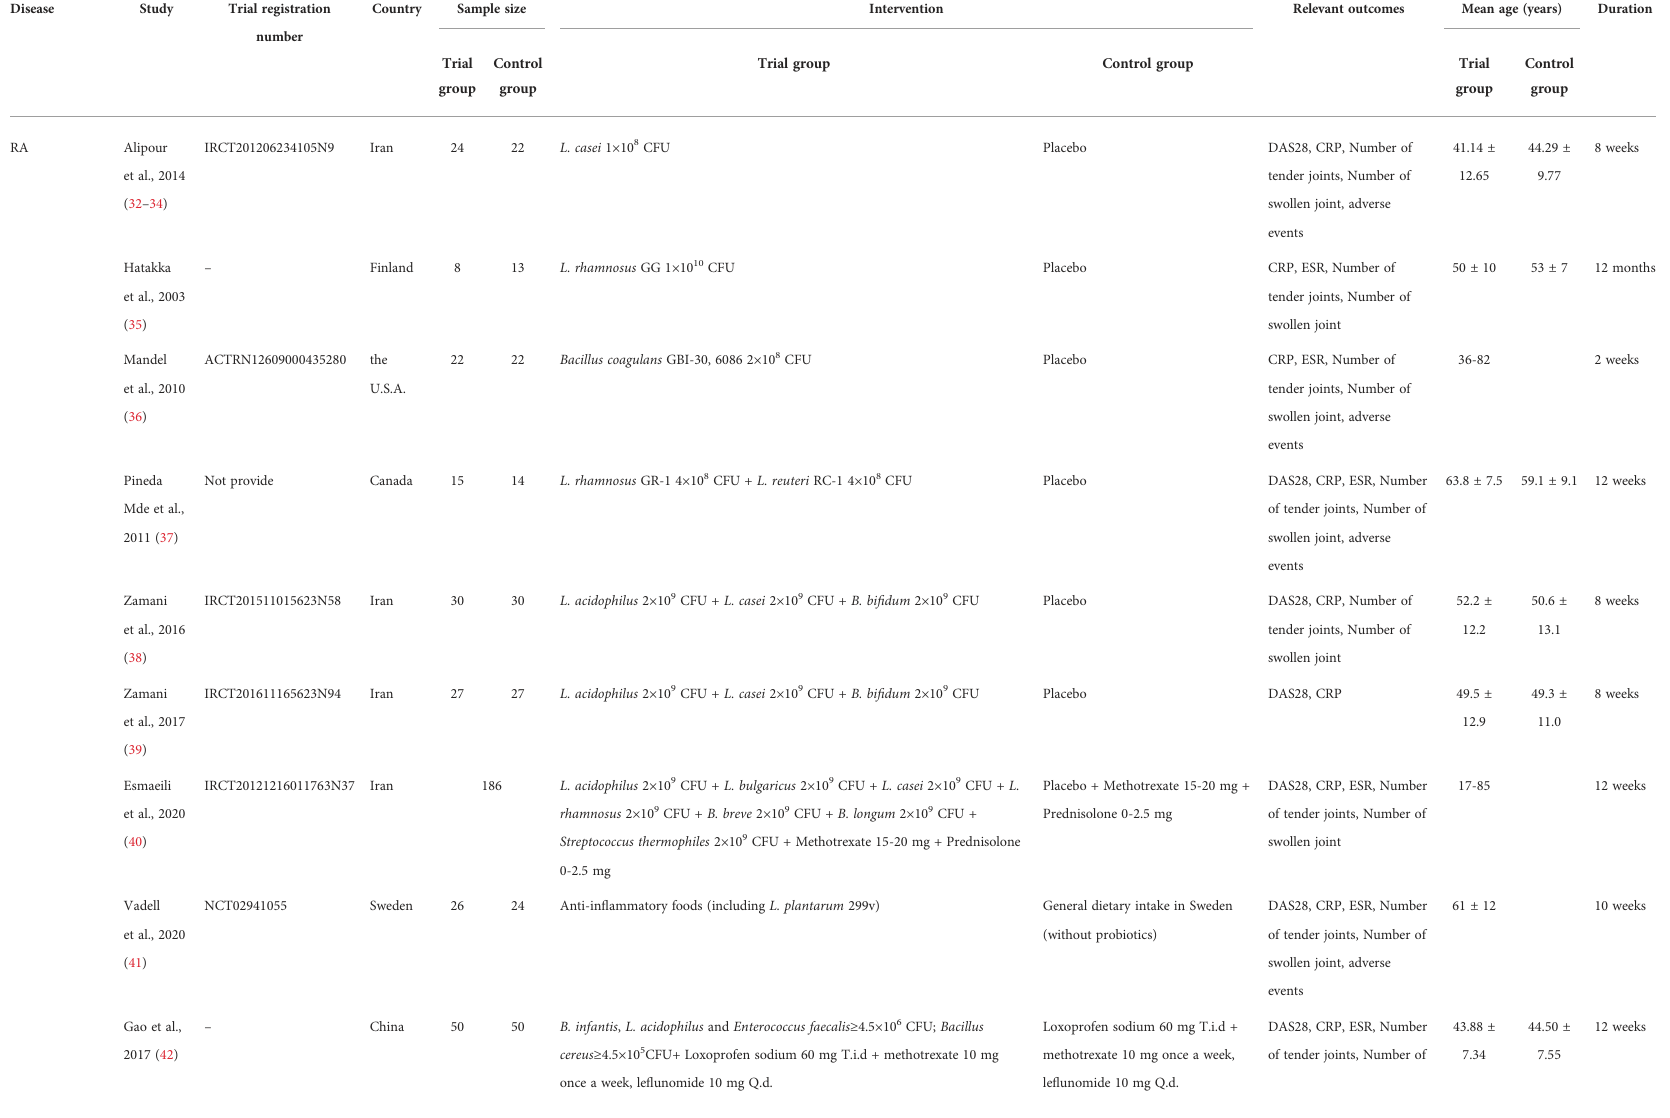
TABLE 1 The characteristics of the included studies.